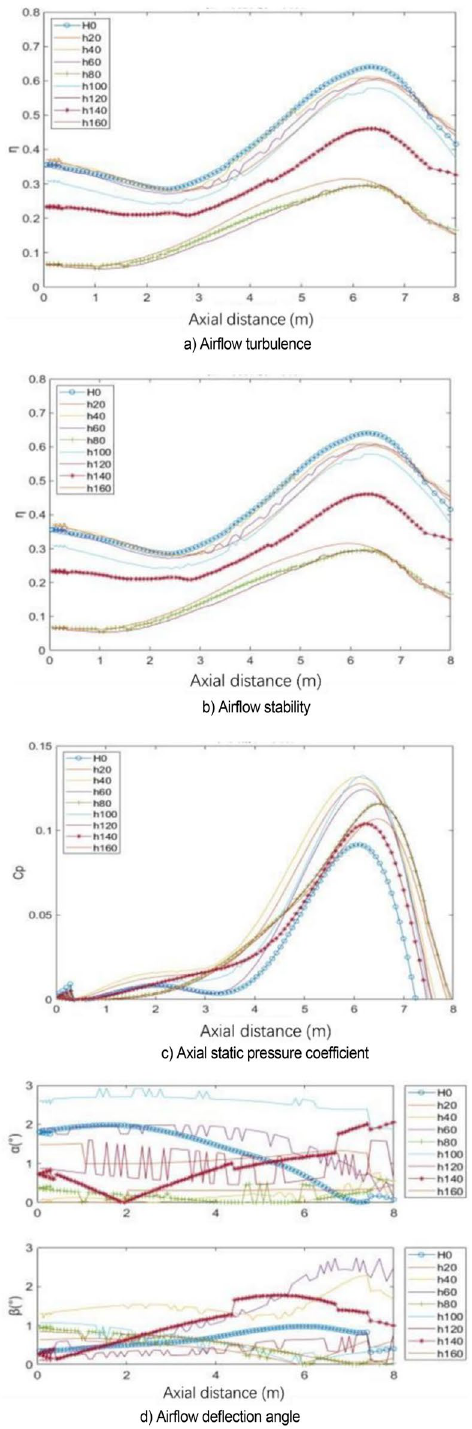
Figure 31. Flow field evaluation